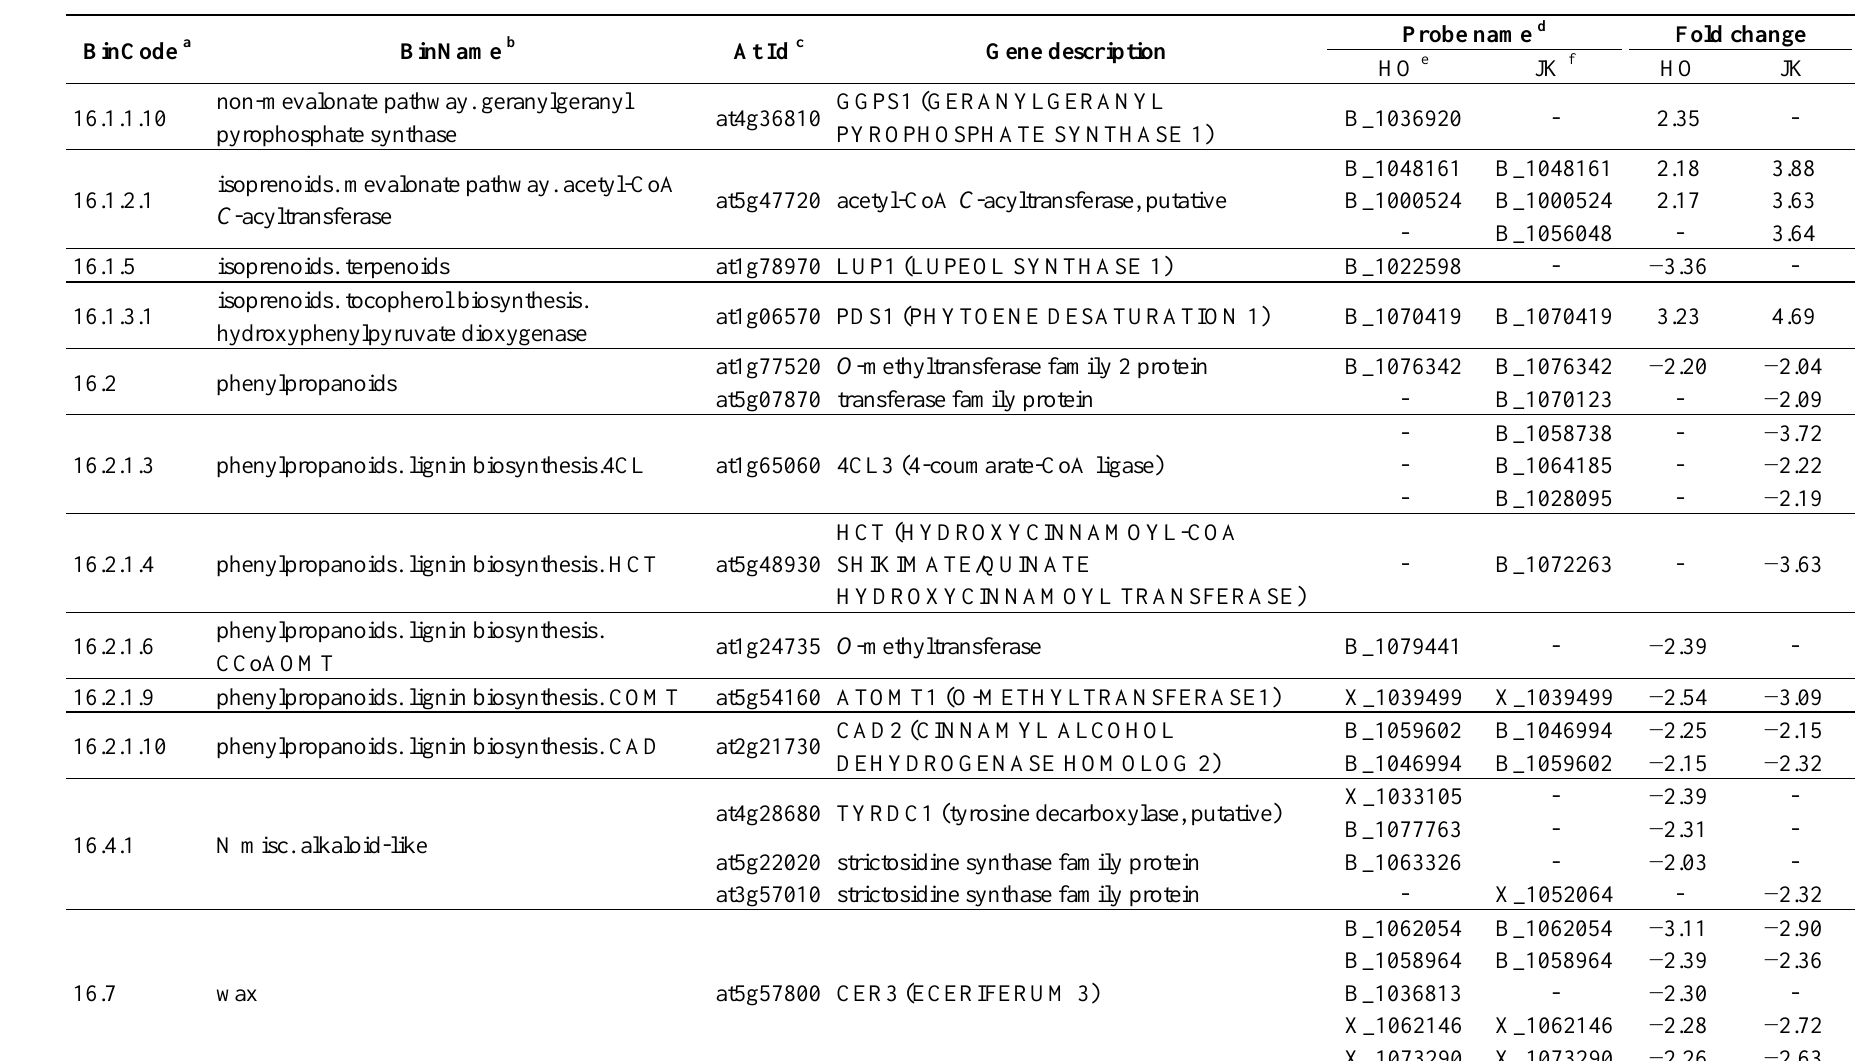
Table 3. Differentially expressed genes were involved in secondary metabolisms in the HO and JK inbred line after heat stress